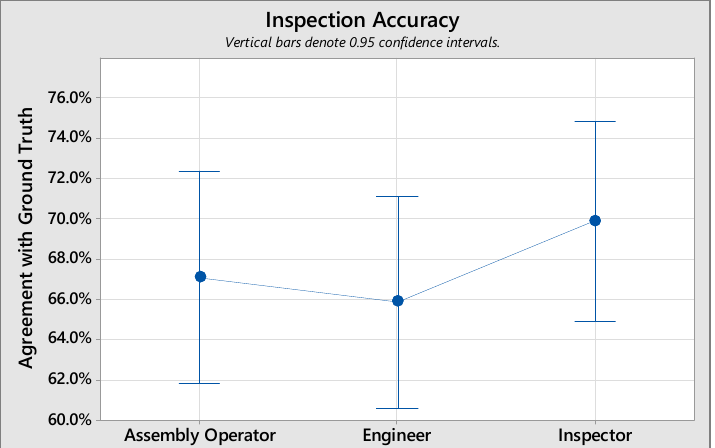
Figure 7. Effect of expertise on inspection accuracy. Data for static images only, without the usual ability to view the blade from different perspectives and tactile feeling of the blade.